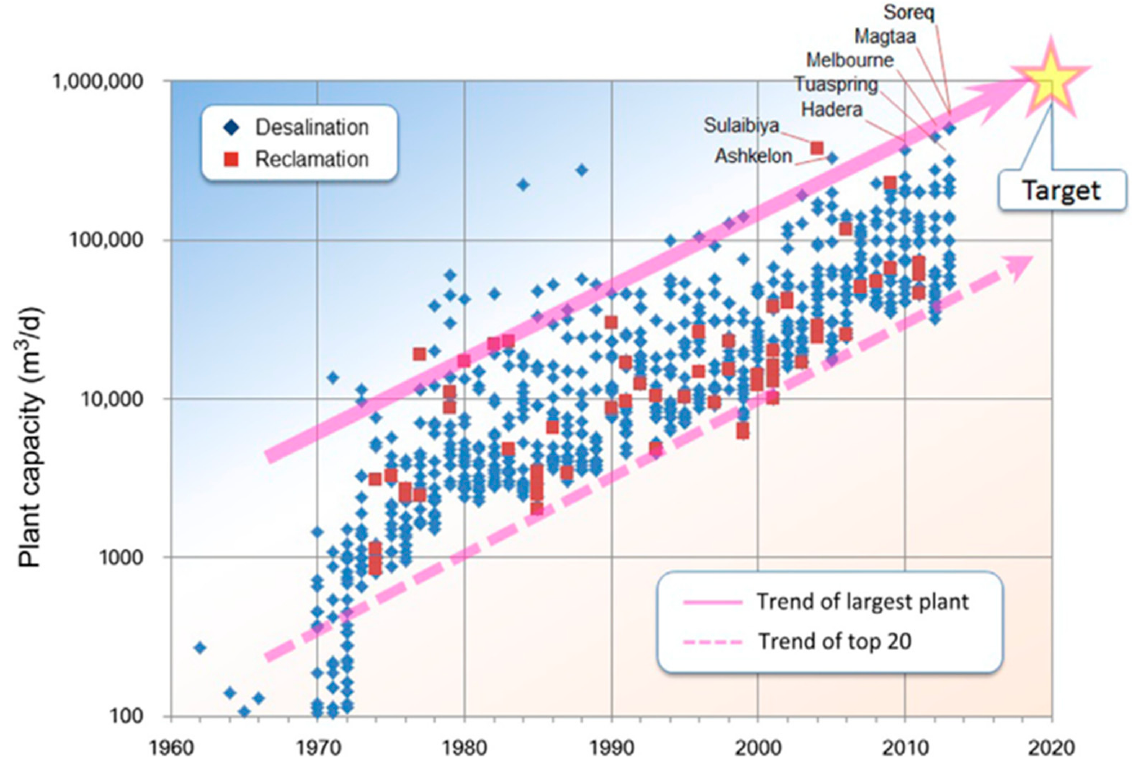
Figure 4. The evolution of plant capacity worldwide over the past 60 years. The solid line shows the trend of the capacity of the largest plant and the dashed line showing that of the top 20 plants [15].